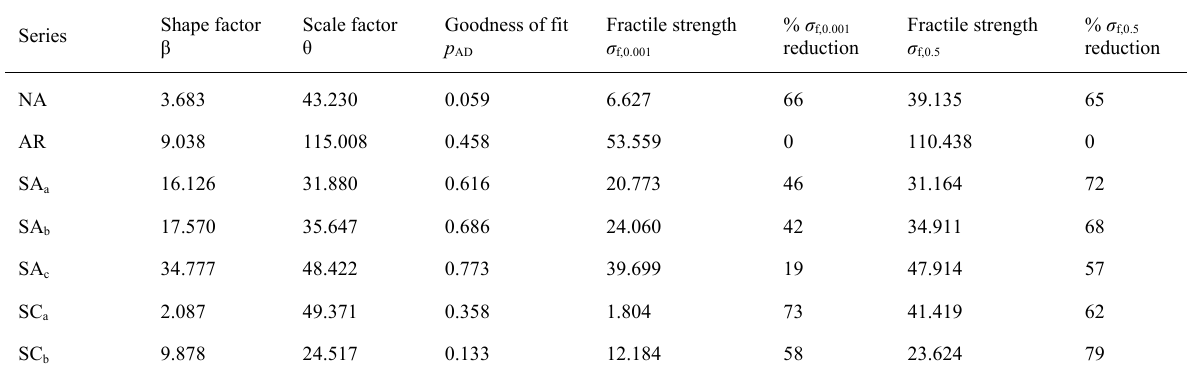
Table 4: Weibull parameters and characteristic fractile values